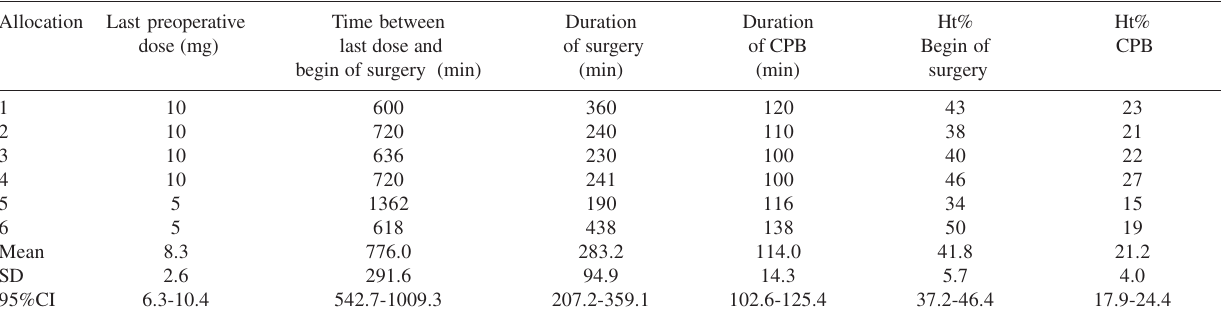
Table 2. Last dose administered before surgery and interval between the administration of the last preoperative propranolol dose and the beginning of surgery.